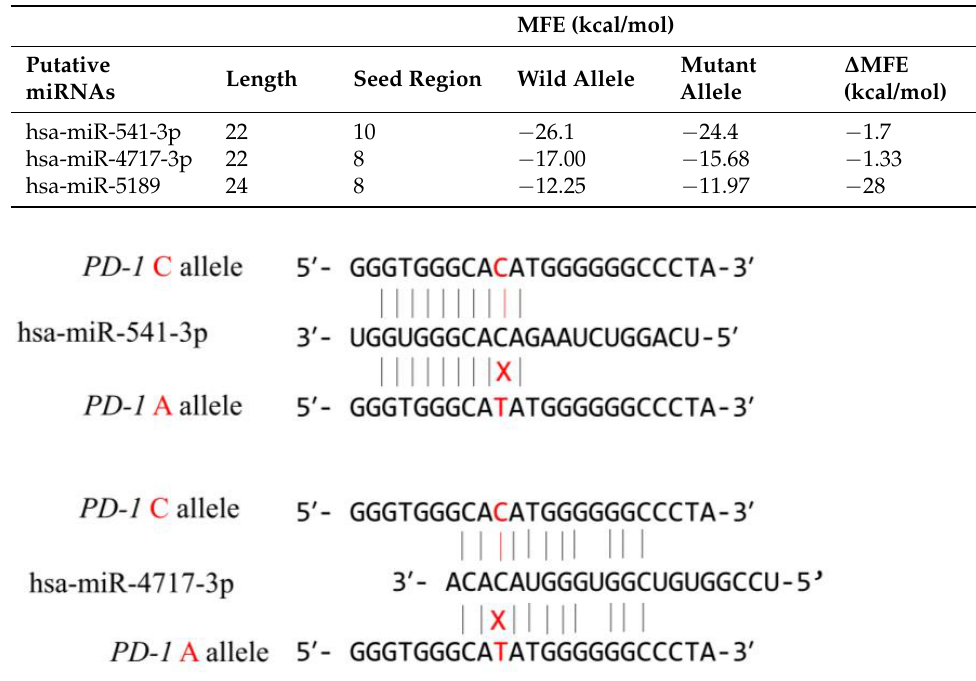
Figure 2. PDCD1 gene expression assessed by qRT-PCR in colon cancer tissues compared to normal matching tissues: (mean ± SD, data normalized to GAPDH, *** p < 0.00 t -test). Table 7. Putative miRNA targeting PD-1.6 SNPs in the 3 (cid:48) UTR of the PD-1 gene, and the difference in the free energy of hybridization ( ∆ FME) for wild-type and variant alleles.